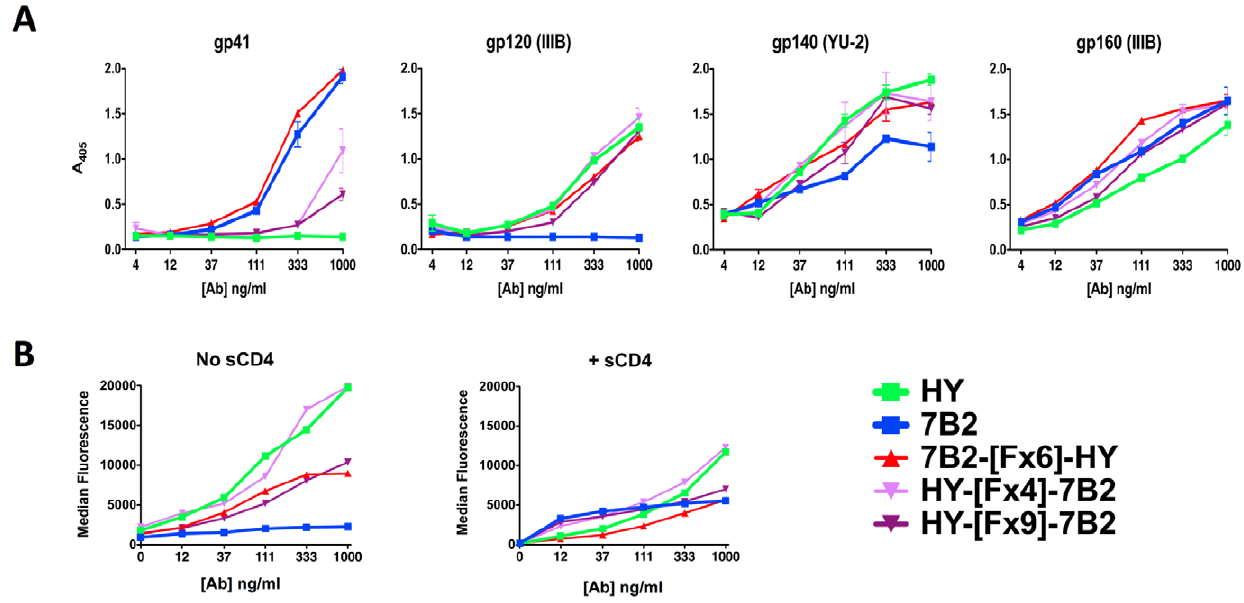
Figure 3. Effect of domain orientation on the binding of DVD-Igs to Env. ELISA (panel A) and flow cytometry (B) were used to evaluate the effects of domain orientation. Binding of DVD-Igs with 7B2 as the external domain was compared to DVD-Igs with HY as the external domain. Experiments were conducted as described in Figure 2. ELISA results are representative of at least 3 assays, FACS of 2.